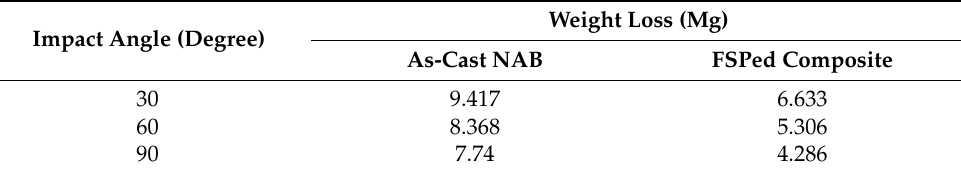
Table 2. Effect of impact angles on weight loss in the as-cast NAB and the FSPed